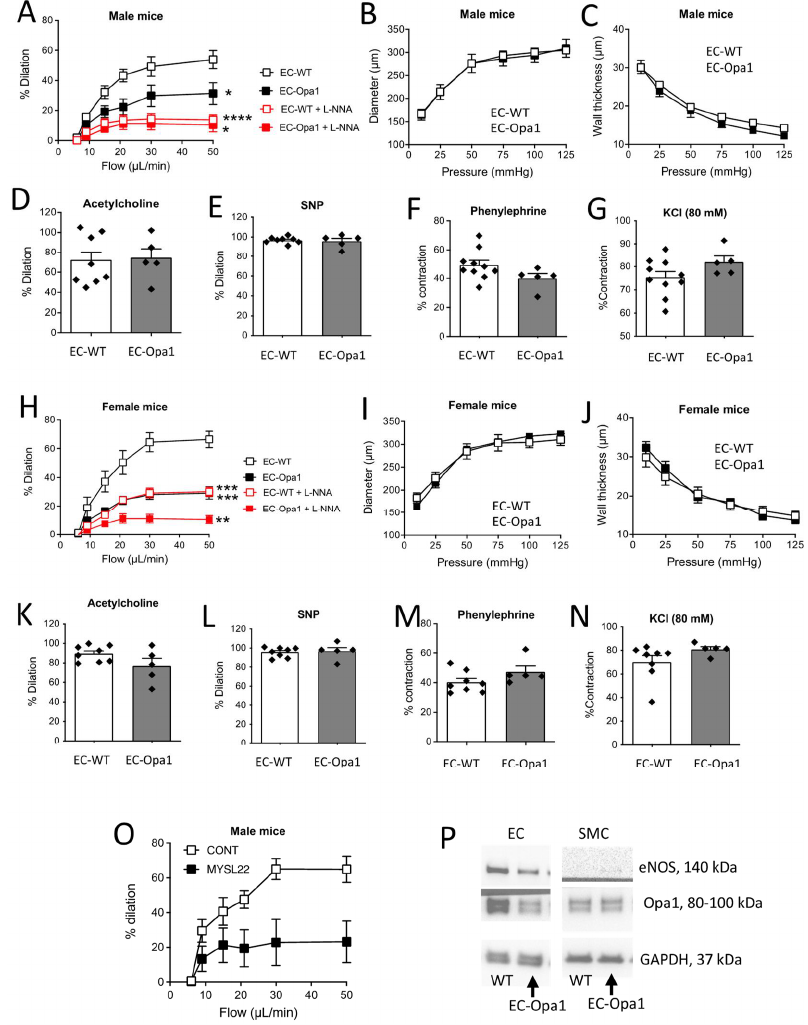
Figure 4. Consequence of Opa1 deficiency in endothelial cells on flow-mediated dilation. Vascular reactivity and structure were measured in mesenteric resistance arteries isolated from EC-WT and EC-Opa1 male ( A – G , O ) and female ( H – N ) mice. FMD ( A , H ) was determined in response to stepwise increases in flow in the presence or absence of the NO synthesis blocker L-NNA 100 µ M, 30 min). In the same arteries, arterial inner diameter ( B , I ) and wall thickness ( C , J ) were measured in response to stepwise increases in pressure. D , K : Acetylcholine (1 µ M)-mediated dilation. E , L : sodium nitroprus- side (SNP, 10 µ M)-mediated dilation. F , M : Phenylephrine (1 µ M)-mediated contraction. G , N : KCl (80 mM)-mediated contraction. In a separate series of experiments, the effect of the Opa1 inhibitor MYSL22 (1 µ M, 30 min) was tested on FMD ( O ). Panel P : Validation of Opa1 extinction in mesenteric resistance arteries endothelial cells (EC) from EC-Opa1 mice compared to smooth muscle cells (SMC) isolated from the same arteries. As a control for the identity of EC, eNOS protein expression was also measured together with GAPDH as a loading marker ( P ). Full blots are shown in Figures S5 and S6. Means ± SEM are shown (n = 8 male EC-WT, 5 male EC-Opa1, 8 female EC-WT and 5 EC-Opa1 mice in panels A to N and n = 4 male EC-WT with MYSL22 and 5 male EC-WT with solvent or control in panel O ). Two-way ANOVA for repeated measurements: Panel A: * EC-Opa1 vs EC-WT: p = 0.0213, interaction p = 0.0045, **** LNNA in EC-WT: p < 0.0001, interaction p < 0.0001; * LNNA in EC-Opa1: p = 0.0198, interaction p = 0.0065. Panel H: *** EC-Opa1 vs EC-WT p = 0.00006, interaction p < 0.0001; *** LNNA in EC-WT: p = 0.0007, interaction p < 0.0001; ** LNNA in EC-Opa1: p = 0.0028, interaction p < 0.0001. Panel O : * p = 0.0221, interaction p = 0.0228. NS: Two-way ANOVA for repeated measurements ( B , C , I , J ). NS, two-tailed Mann–Whitney test, panels D – G and K – N